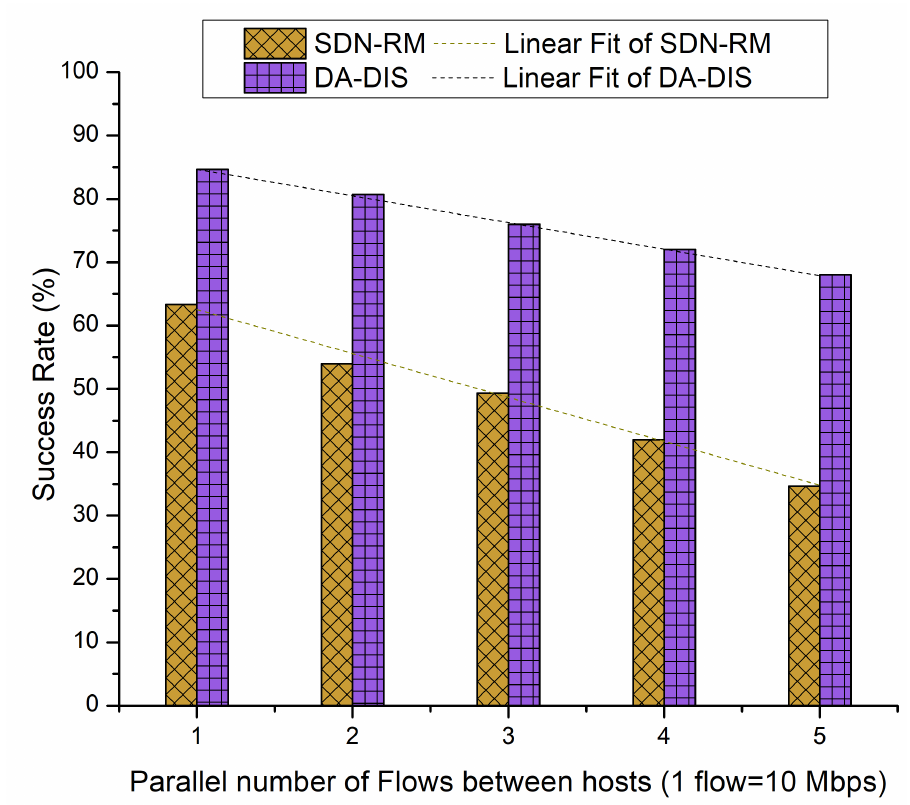
Figure 18. Success rate considering different numbers of parallel flows with one malicious switch along with E1 and E2 category